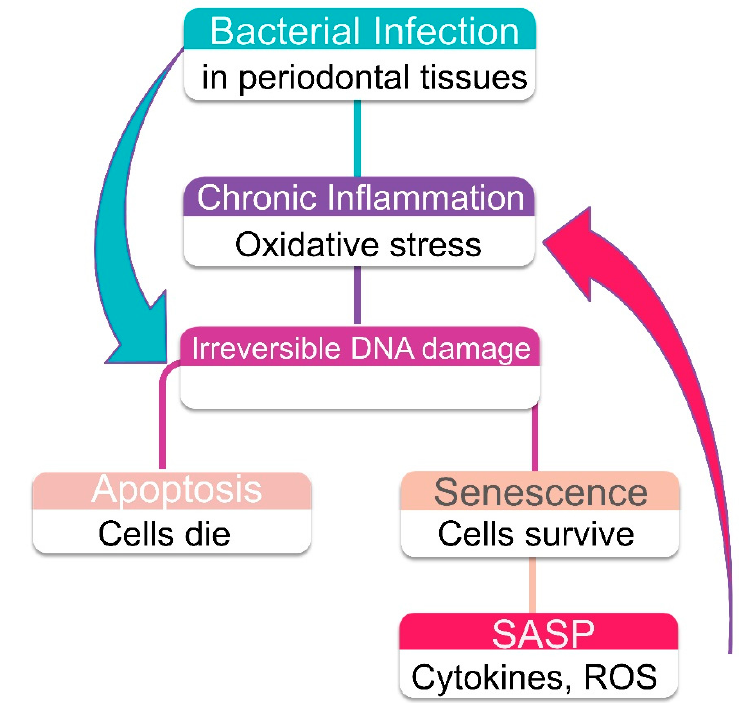
Figure 4. Senescent cells in periodontal tissues are an additional source of proinflammatory factors. Senescence-associated factors can potentially interact and exacerbate bacteria-induced chronic inflammation. NF- κ B activation plays an important role in bacterial recognition and nuclear DNA damage signaling.